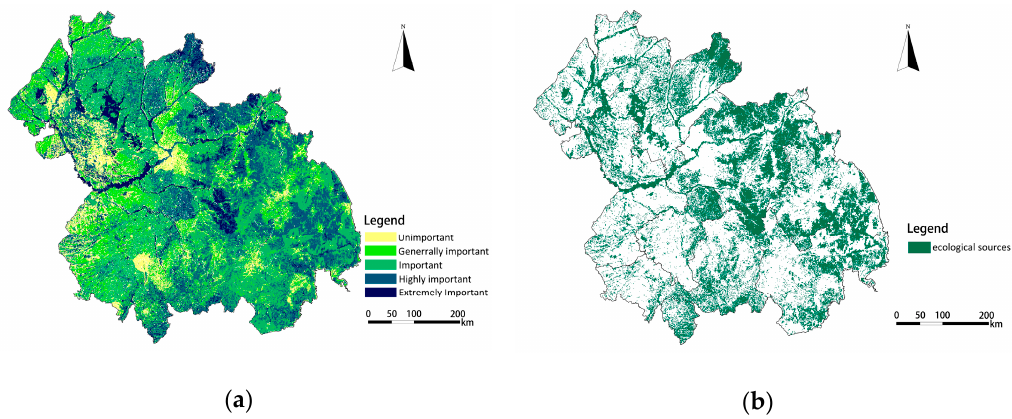
Figure 4. The importance grades of ecological services and their spatial distribution: ( a ) The importance grades of ecological services; ( b ) The spatial distribution of ecological